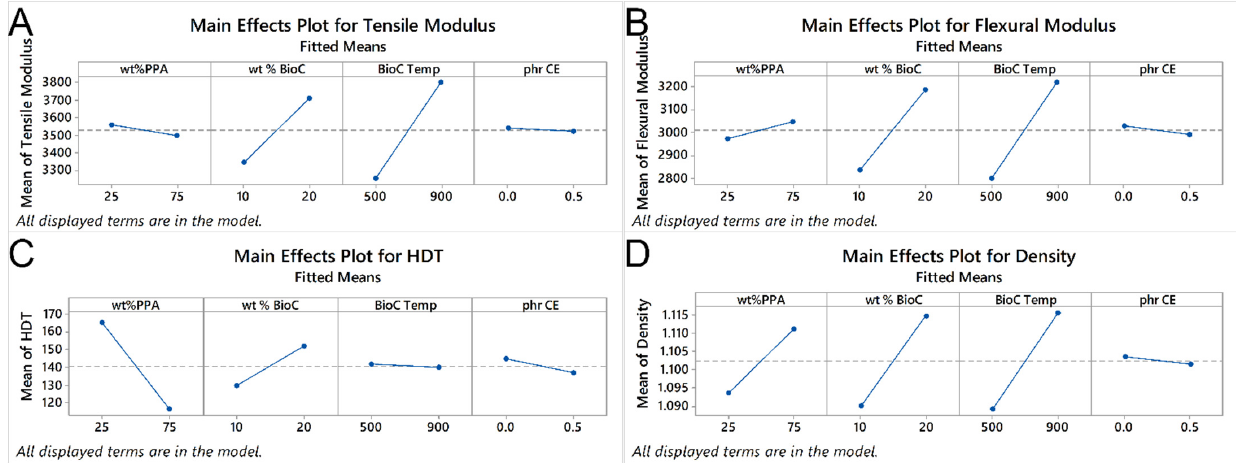
Figure 4. Main effects that the four different factors, wt% PPA, wt% BioC, the temperature of pyrolysis of BioC and the presence of chain extender, have on ( A ) tensile modulus, ( B ) flexural modulus, ( C ) HDT and ( D ) density.